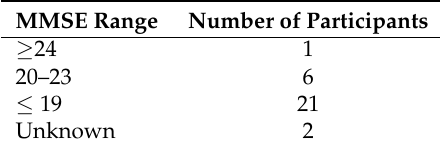
Table 4. MMSE-K results of the